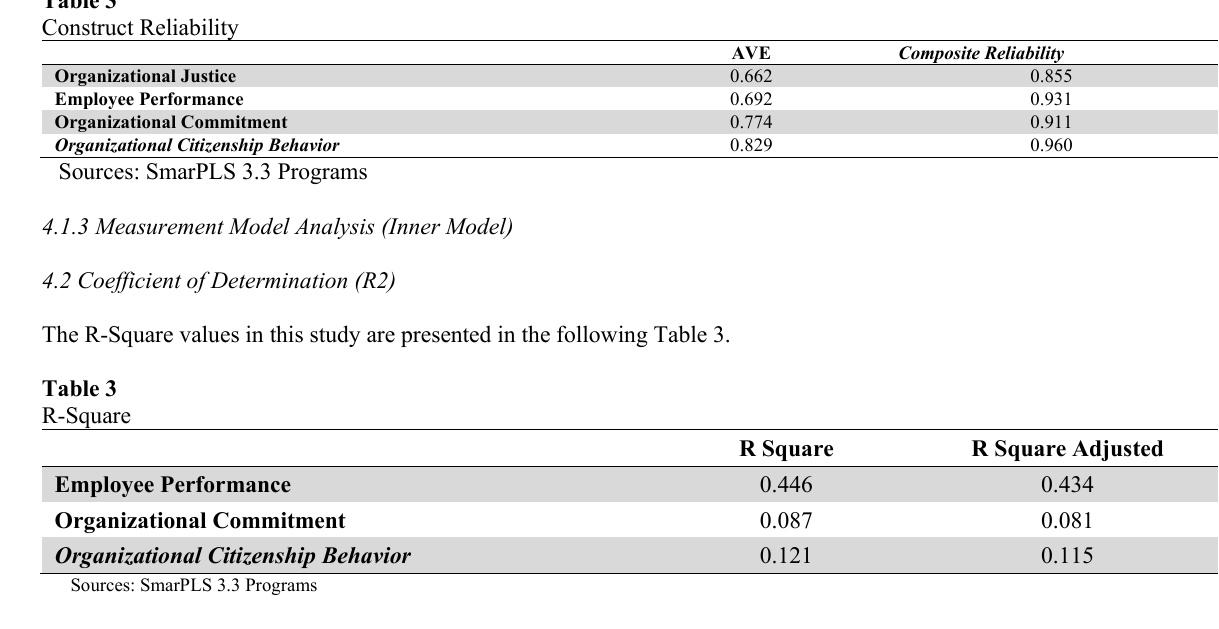
R Square R Square